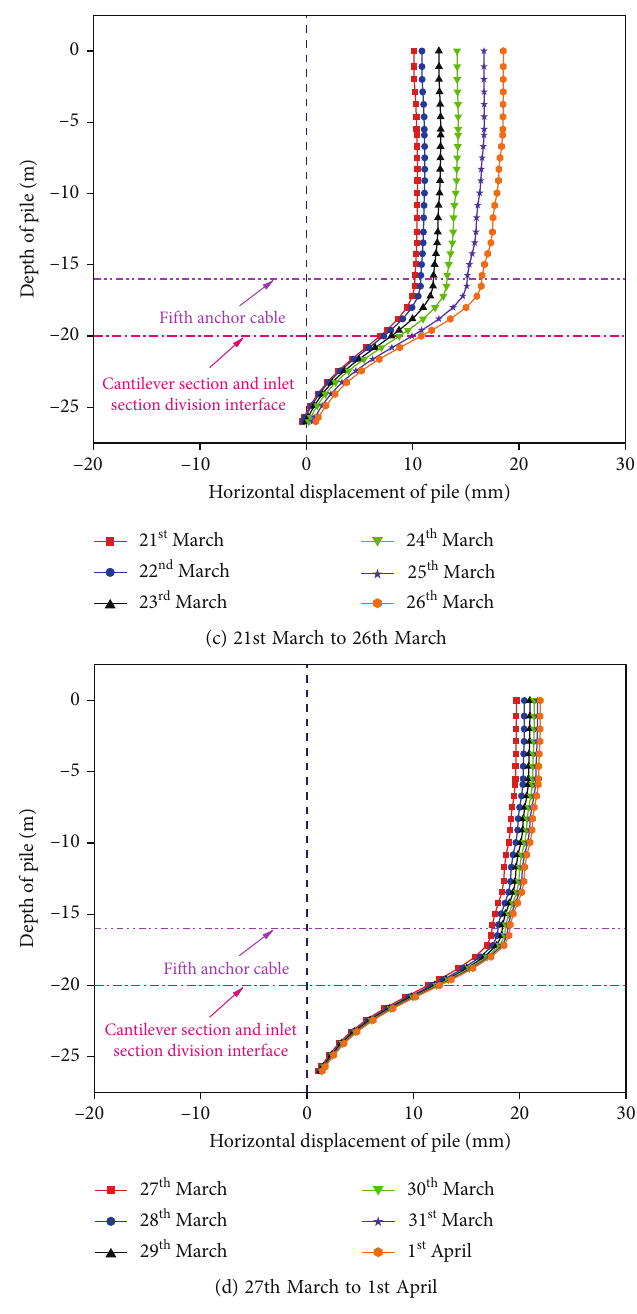
Figure 9: Variation in the pile horizontal displacement during the spring